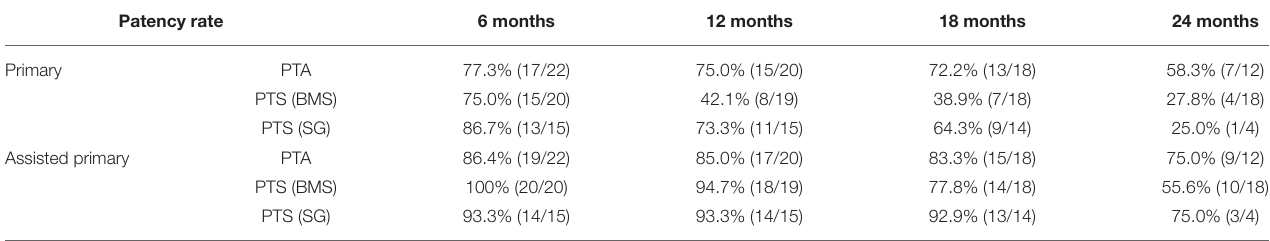
TABLE 4 | Primary and assisted primary patency rate for different primary